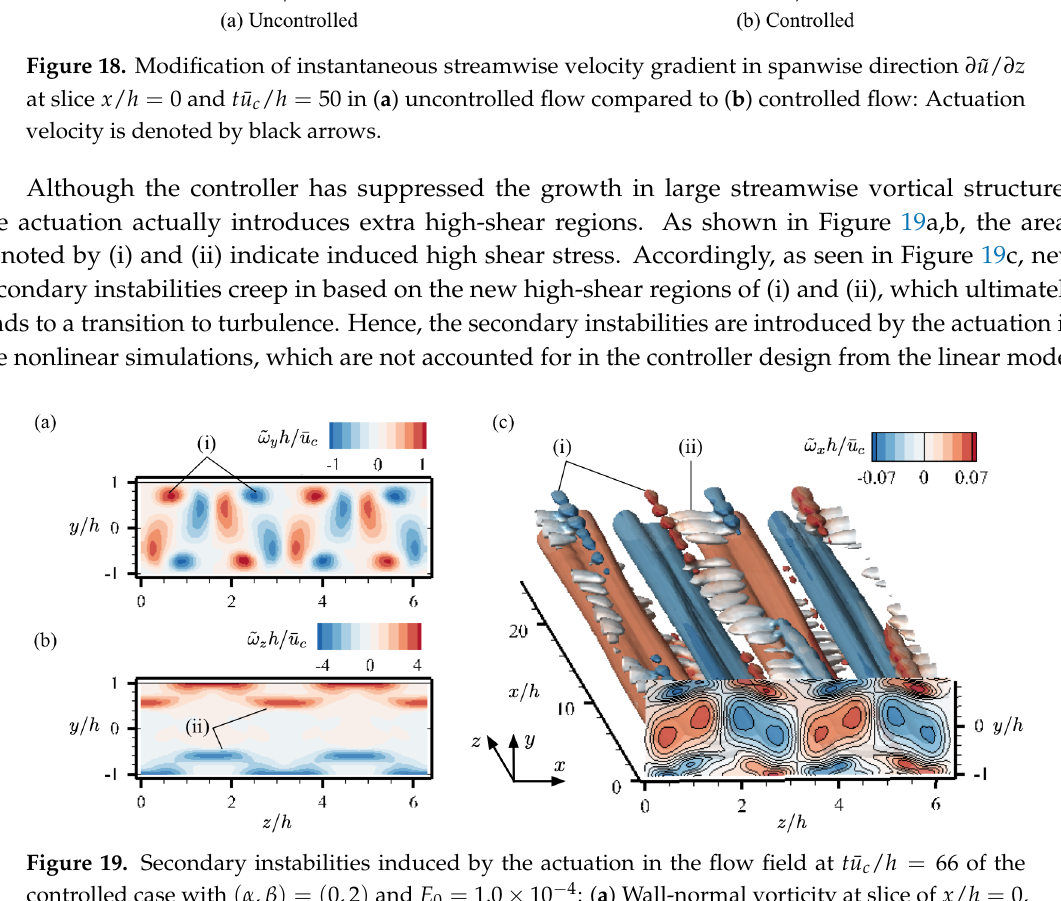
10 − 4 : ( a ) Wall-normal vorticity at slice of x / h = 0, × colored by streamwise Q